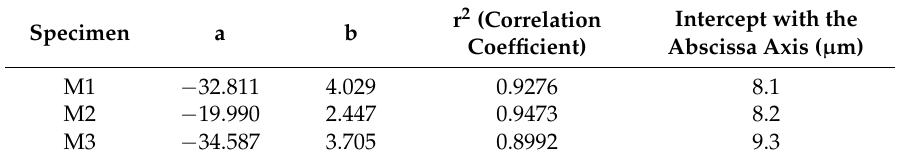
Figure 8. Evolution of the crack widths of the mortar specimens in function of the losses of the effective radius of the steel bars, calculated through Equation (3). Table 3. Fitting parameters of Equation (4) to the sets of data of Figure